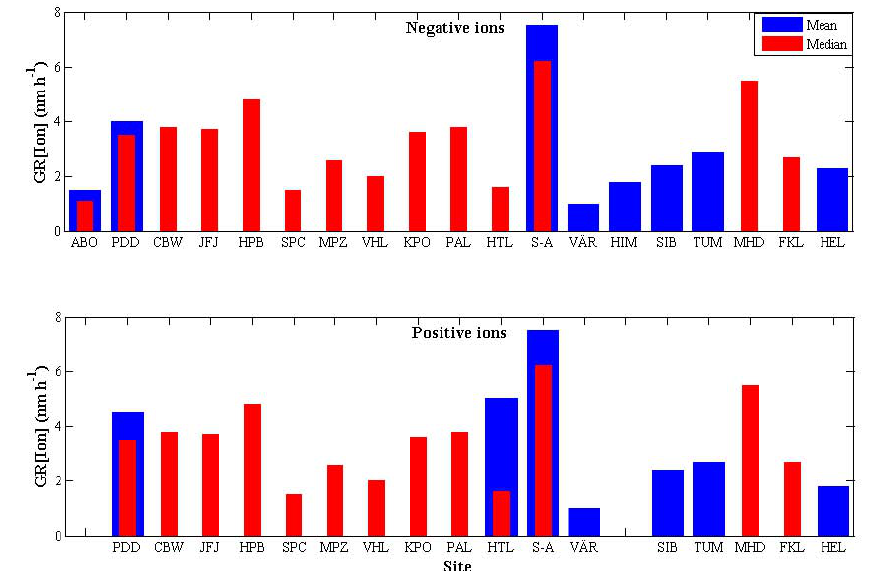
Fig. 8. The mean (blue bar) and median (red bar) GR[ion] as a function of site in rural, marine and urban environ- ments for negative ions (top panel) as well as for positive ions (bottom panel). ABO = Aboa, PDD = Puy de Dˆome, CBW=Cabauw, JFJ=Jungfraujoch, HPB=Hohenpeissenberg, SPC=San Pietro Capofiume, MPZ=Melpitz, VHL=Vavihill, PAL=Pallas, HTL=Hyyti¨al¨a, TAH=Tahkuse, S-A=South-Africa, V ¨AR=V¨arri¨o, HIM=Himalaya, SIB=Siberia, TUM=Tumbarumba, MHD=Mace Head, FKL=Finokalia,